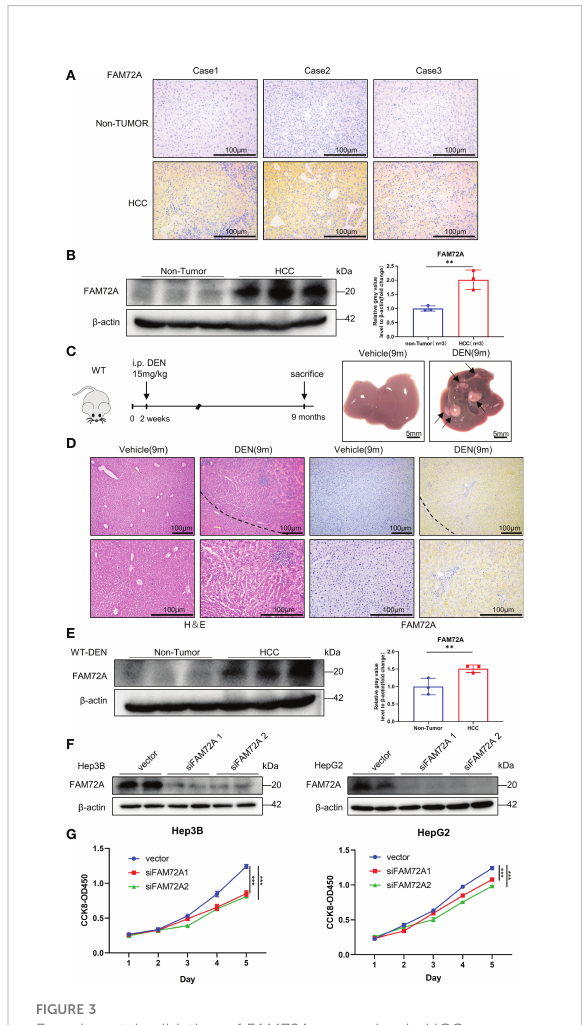
FIGURE 3 Experimental validation of FAM72A expression in HCC. (A) Representative images of FAM72A staining in human HCC and paracancerous tissues from each patient. Scale bar: 100 m m. (B) FAM72A protein expression in human HCC and paracancerous tissues from each patient was determined